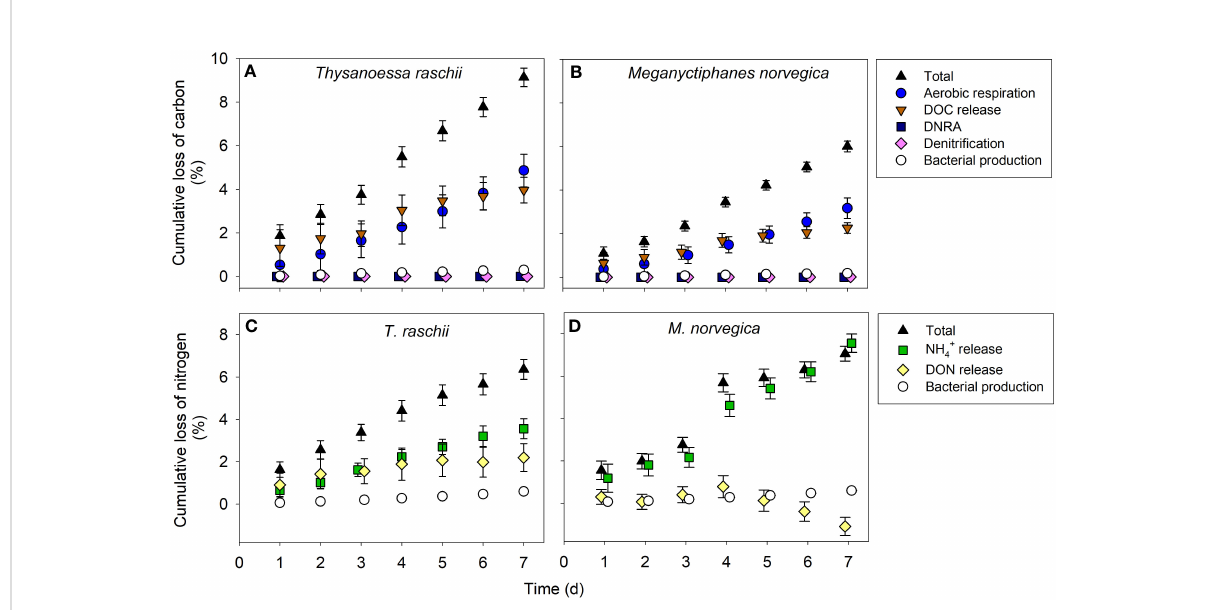
FIGURE 5 Cumulative loss of carbon and nitrogen from krill carcasses. Cumulative loss of carbon through aerobic respiration, Dissolved Organic Carbon (DOC) release, denitri fi cation, dissimilatory nitrate reduction to ammonium (DNRA), and bacterial production in carcasses of (A) Thysanoessa raschii and (B) Meganyctiphanes norvegica . The contribution of denitri fi cation and DNRA to carbon mineralization is presented in detail in the supplementary material (Supplementary Figure S4). Cumulative loss of nitrogen from krill carcasses through Dissolved Organic Nitrogen (DON) release, ammonium (NH 4+ ) release, and bacterial production in carcasses of (C) T. raschii and (D) M. norvegica . Mean and standard deviations of 6-7 replicates are shown.